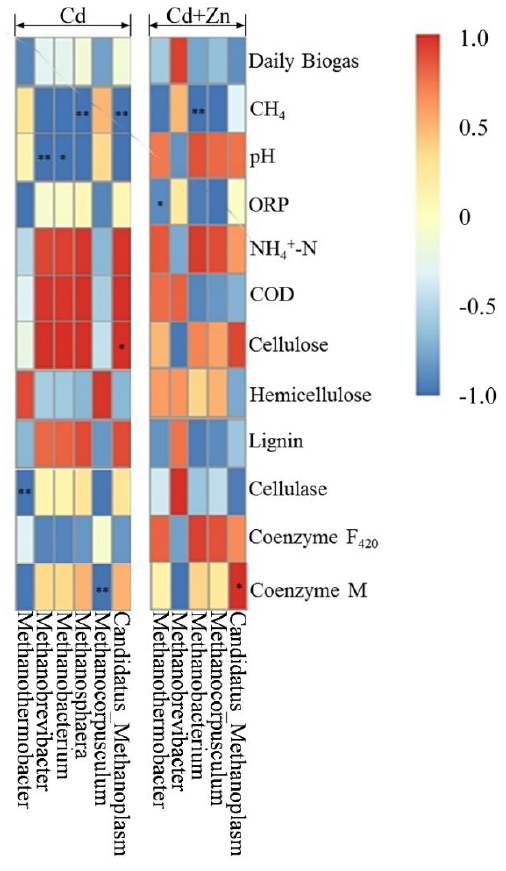
Figure 10. Pearson correlation analysis between environmental factors and methanogen under Cd and Cd + Zn addition during the fermentation.